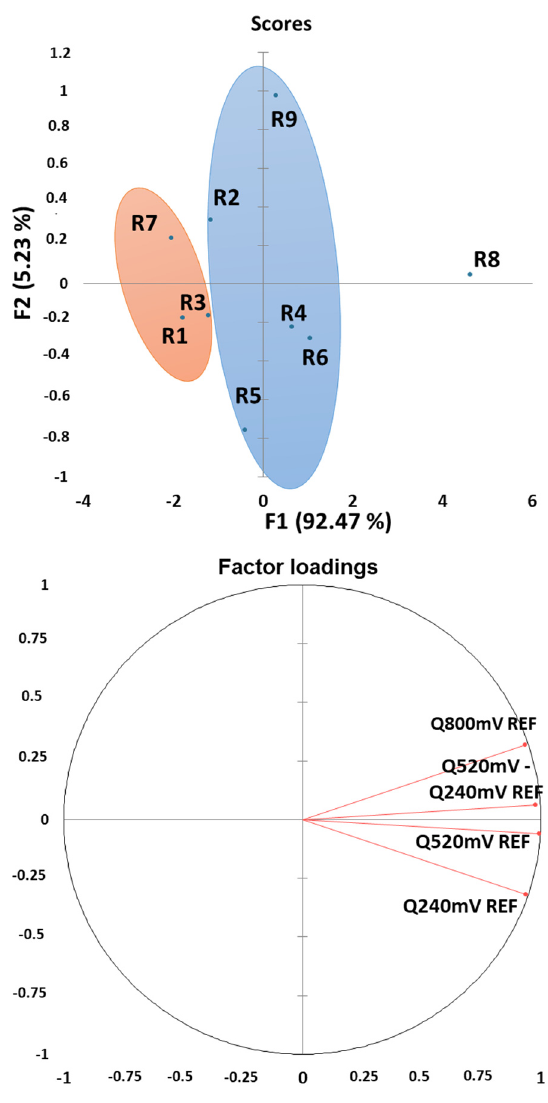
Figure 5. Representation of the loadings (variables—electrochemical parameters (except Q 240mV /Q 800mV ratio) for the reference wines) and the scores (wines) in the plane defined by respec- tively the first (F1) and second (F2) factor (explained variance: 97.74%).